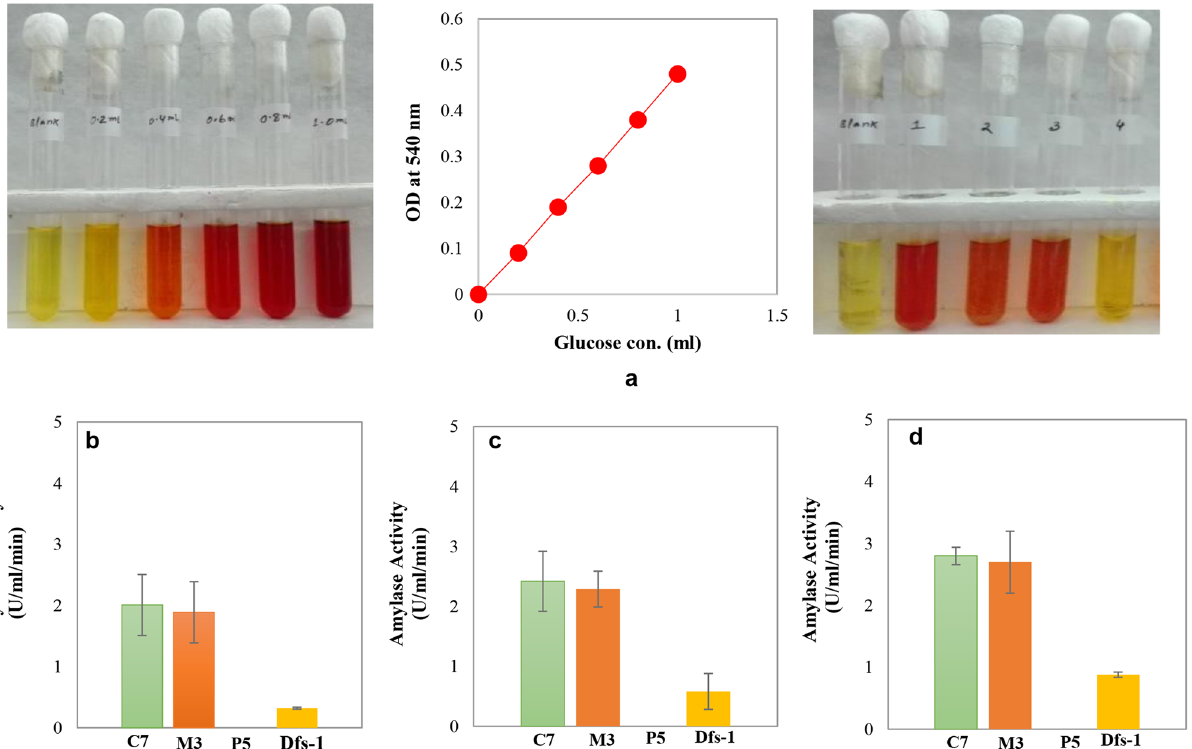
Figure 2. Amylolytic activity of selected starch fermenting microorganisms. Here, in image ( a ) the left and right panels represent glucose standard solutions (0.0 ml, 0.2 ml, 0.4 ml, 0.6 ml, 0.8 ml and 1.0 ml) and experimental samples, respectively. The image in the middle represents the standard glucose curve based on the value estimated from the image on the left. Number 1–4 of every 4-tube from the right image represent samples identified as C-7, M-3, Dfs-1 and P5 respectively. Herein ( b ), ( c ) and ( d ) represents amylase activity of screened strains at 30 °C, 37 °C and 42 °C respectively. One unit (IU) of amylase activity was defined as the amount of enzyme required to release 1 µmole of glucose (from starch hydrolysis) in 1